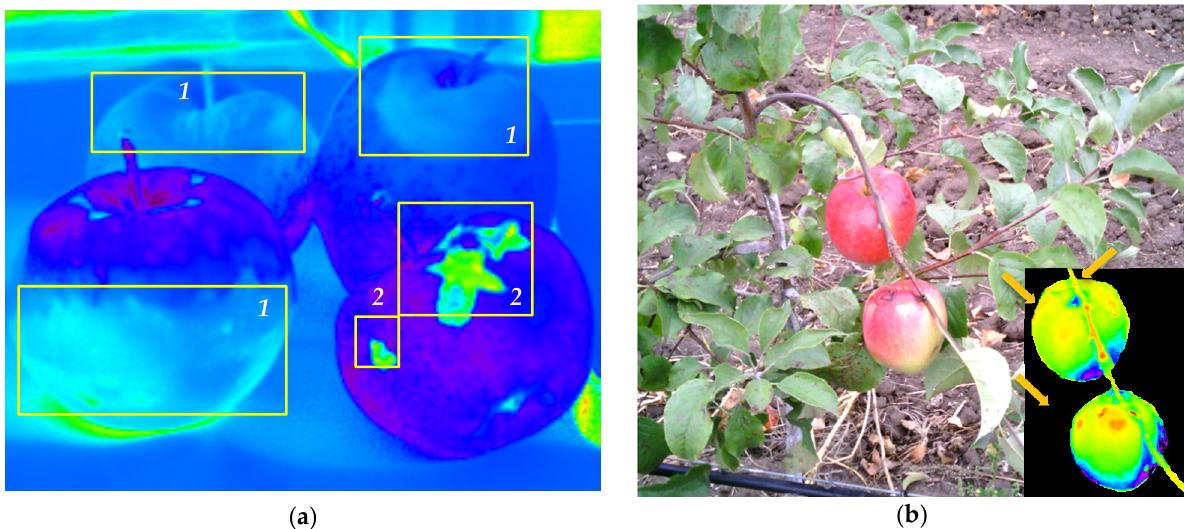
Figure 5. Using the mBRI index for the detection of damages in the HRI images of Ligol apple fruits obtained at ambient illumination. ( a ) Regions of apple fruit affected by ( 1 ) sunscald-induced browning and ( 2 ) scab-induced necroses highlighted in the false-color images based on the calculated values of the mBRI index. ( b ) RGB images reconstructed from a HRI obtained in a commercial orchard. Inset: the same scene, in masked false-color, reflecting the mBRI values revealing the onset of sunscald-induced damages (arrows). Violet-to-blue colors correspond to the low mBRI values (healthy tissues), green colors correspond to intermediate mBRI values (moderately affected tissues), and yellow-to-red colors correspond to high mBRI values (severely affected tissues).